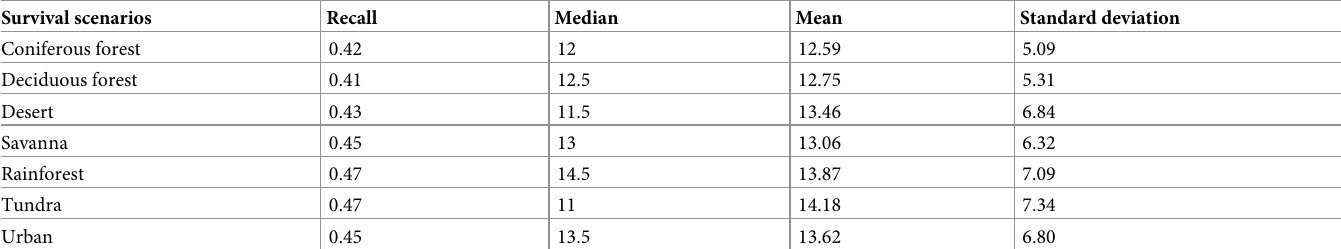
Table 3. Median differences (Kruskal–Wallis) and the descriptive analysis of the proportion correct recall in the survivor scenarios. Survival